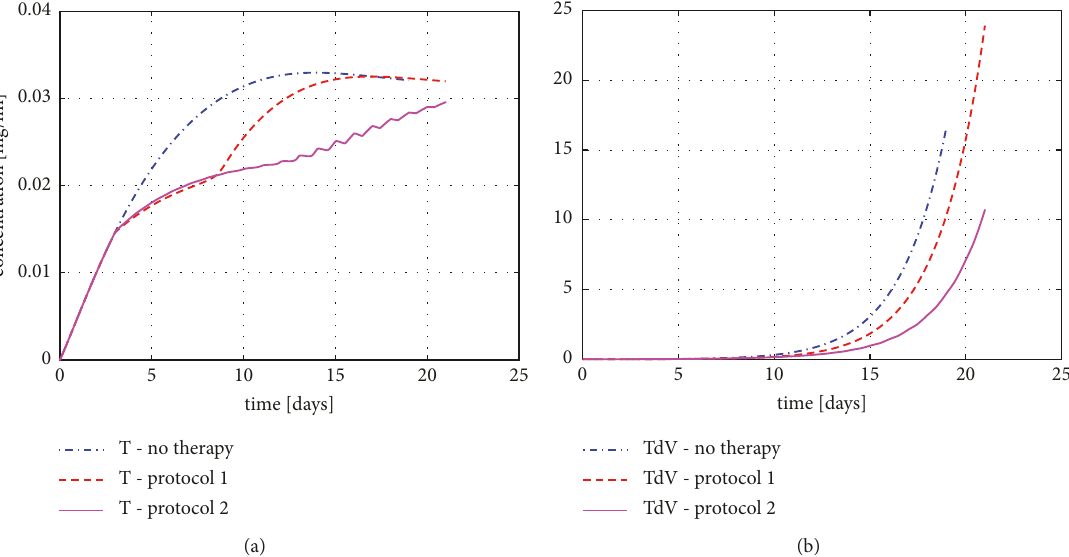
Figure 6: (a) Concentration of TAF ( 𝑇 ) in the case of various therapies; (b) TAF-dependent vascularization (TdV) in the case of different